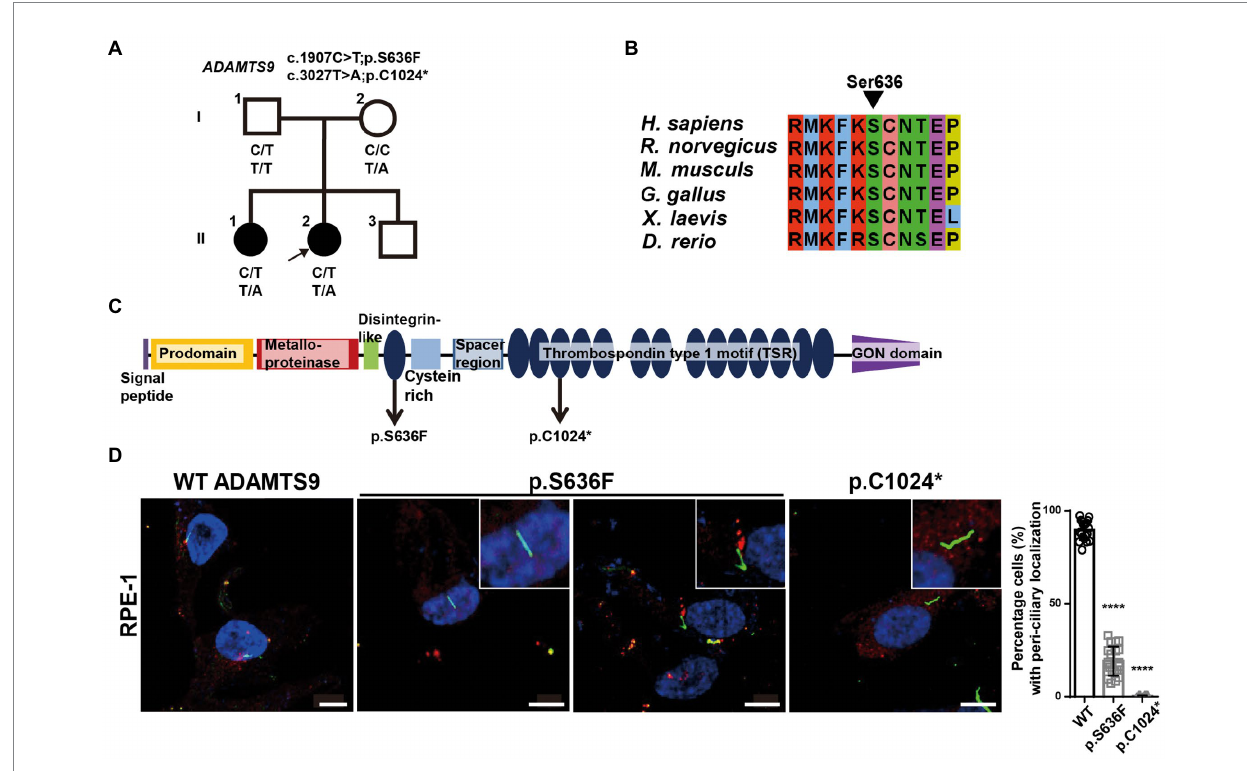
FIGURE 1 ADAMTS9 variants identified in patients with NPHP. (A) Pedigree of the family with NPHP. (B) The newly identified ADAMTS9 mutations altered the evolutionary conserved amino acid residues in the ADAMTS9 protein. (C) Domain structure of wildtype (WT) ADAMTS9 and NPHP-associated variants. (D) Localization of overexpressed ADAMTS9 in RPE1 cells. Cells were transfected with V5 tagged WT and mutant ADAMTS9 cDNA constructs, serum starved for 48 h, and stained with anti-Ac- α -tubulin and anti-V5 antibodies. Quantification is shown in the right panel. Scale bar, 10 μ m. **** p <